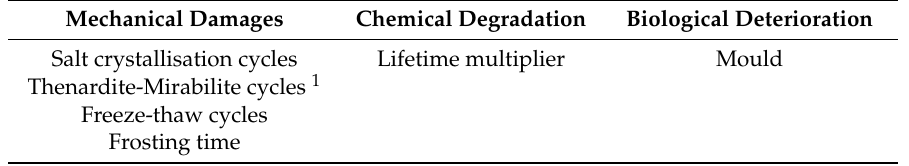
Table 4. The main variables to estimate indoor deterioration in masonry and concrete